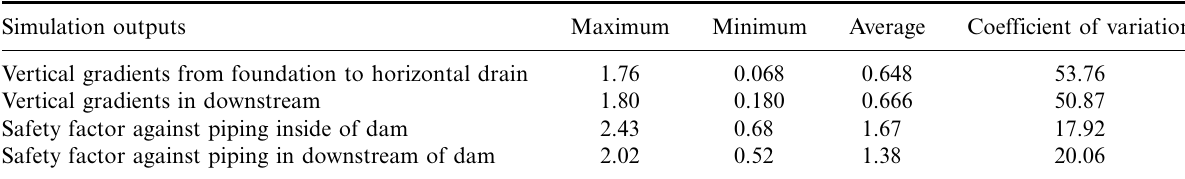
Table 5. Monte Carlo finite difference simulation for the first scenario Simulation outputs